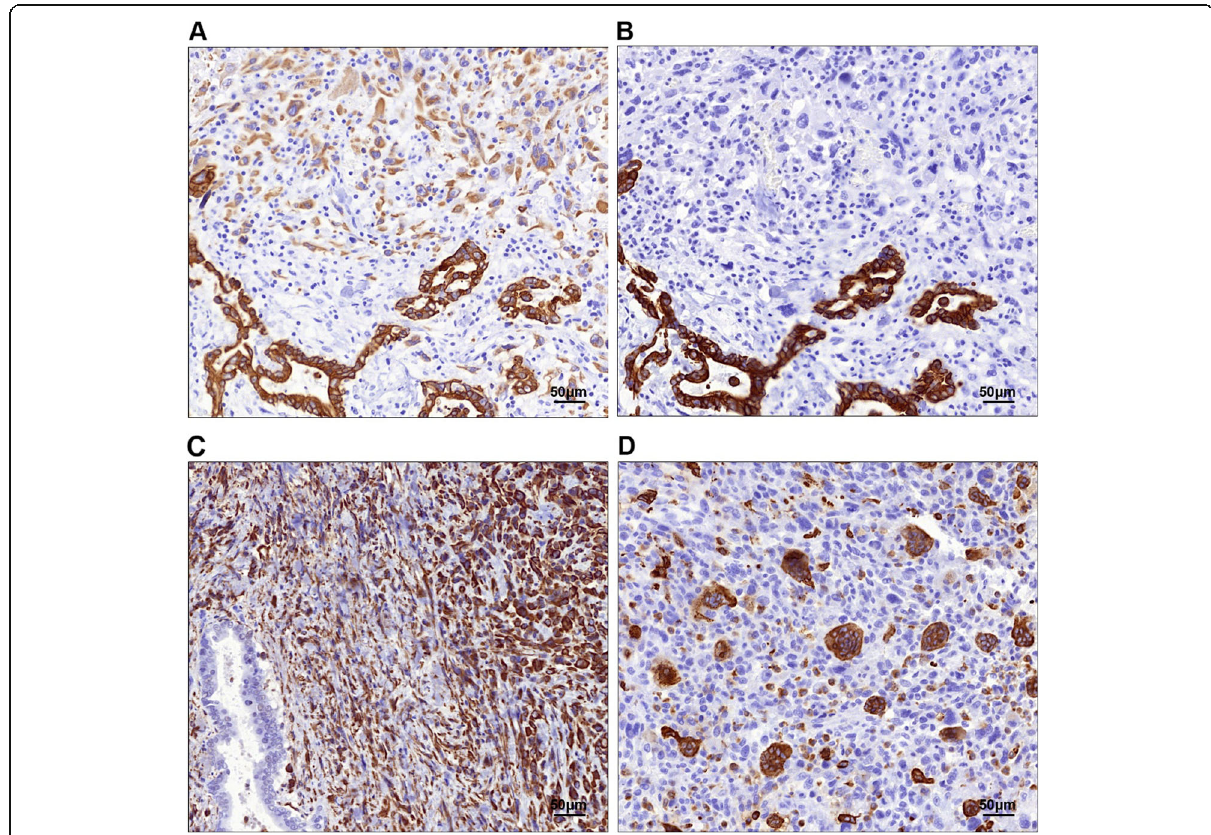
Fig. 4 IHC findings of the undifferentiated carcinoma. a Cells in both the tubular and undifferentiated components were stained for AE1/AE3. b Positive immunostaining for CK7 was identified only in the cells of the tubular component. c The cells of the undifferentiated component were “ diffuse positive ” for Vimentin. d The osteoclast-like giant cells were strongly positive for CD68. Original magnification: × 200